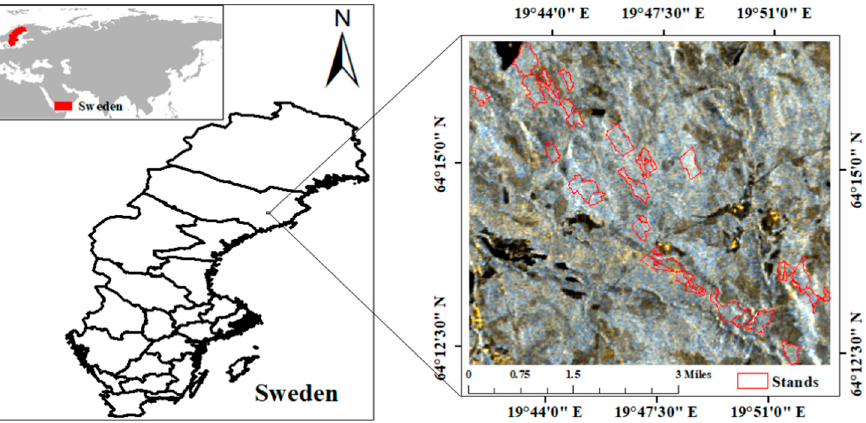
Figure 1. Location of the study area. The background map is the 2008 PALSAR mosaic yearly product (red: HH, green: HH+HV, blue: HV,) and red border polygons are 29 stands.